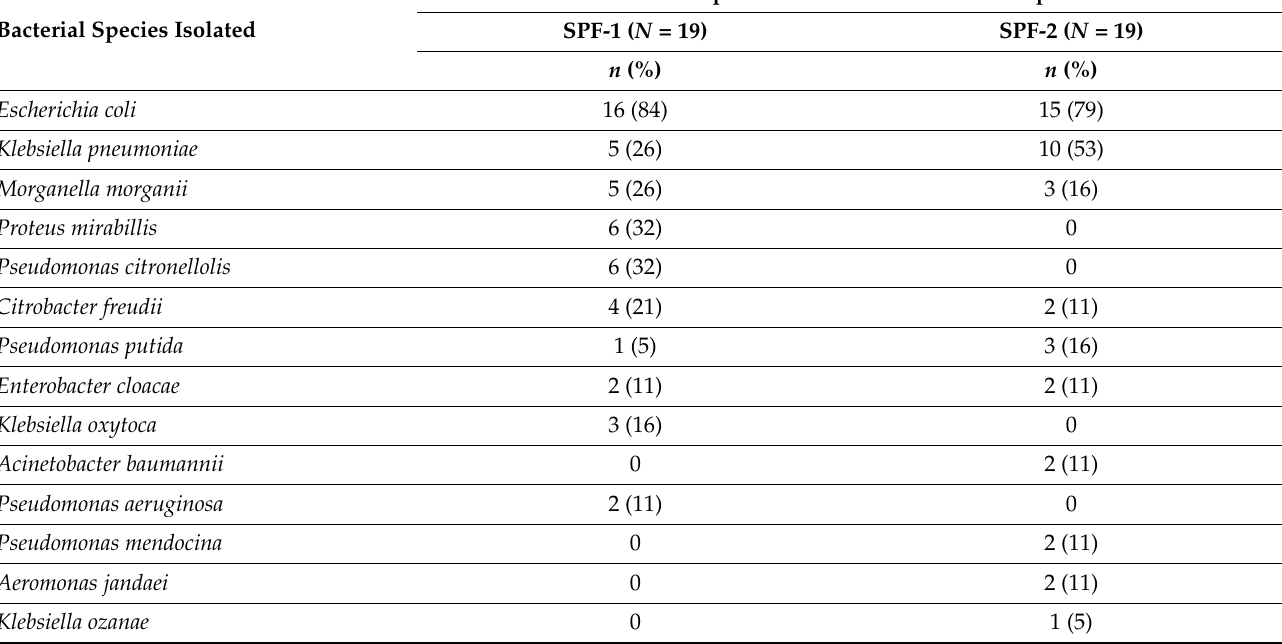
Table 2. Bacterial species isolated from the effluent samples collected from the two seafood processing facilities (SPF) in Tema, Ghana during 2021 and 2022.